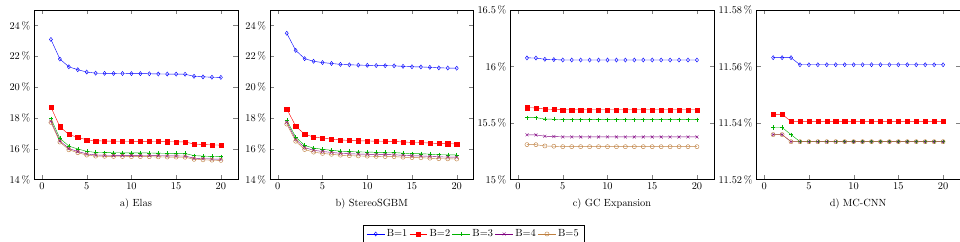
Figure 8. Values of the BMP metric when EEMM was used with algorithms: ( a ) ELAS, ( b ) Stere- oSGBM, ( c ) GC Expansion and ( d ) MC-CNN.